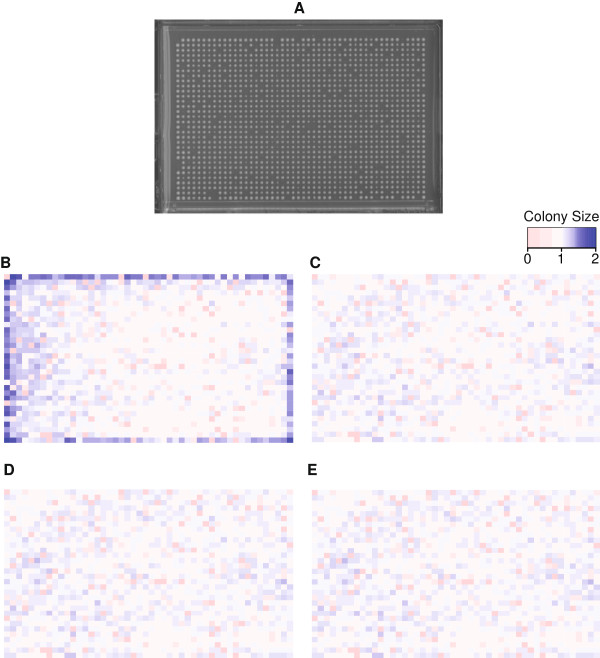
Normalization of quantified colony measurements. A. Scanned image of one of three replicates used in B-E. The shading of each cell represents the corrected colony size as indicated by the color key and each heatmap shows the mean of three biological replicates. B. Heatmap of uncorrected colony sizes. C. Heatmap after applying row/column correction. D. As C, but with spatial correction also applied. E. As D, but with competition correction also applied.